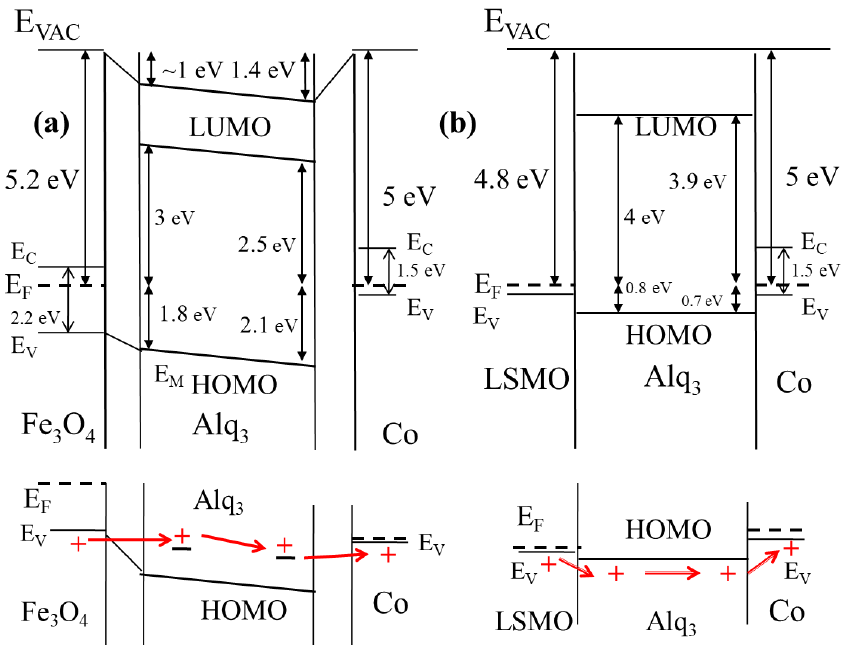
Figure 4. ( a ) Upper section shows equilibrium band structure for Fe 3 O 4 /Alq 3 /Co MTJ. The lower section shows predominant tunneling across the optical band gap of the organic spacer region. ( b ) The upper section shows the equilibrium band structure for LSMO/Alq 3 /Co MTJ. The lower section indicates predominant carrier injection across the organic